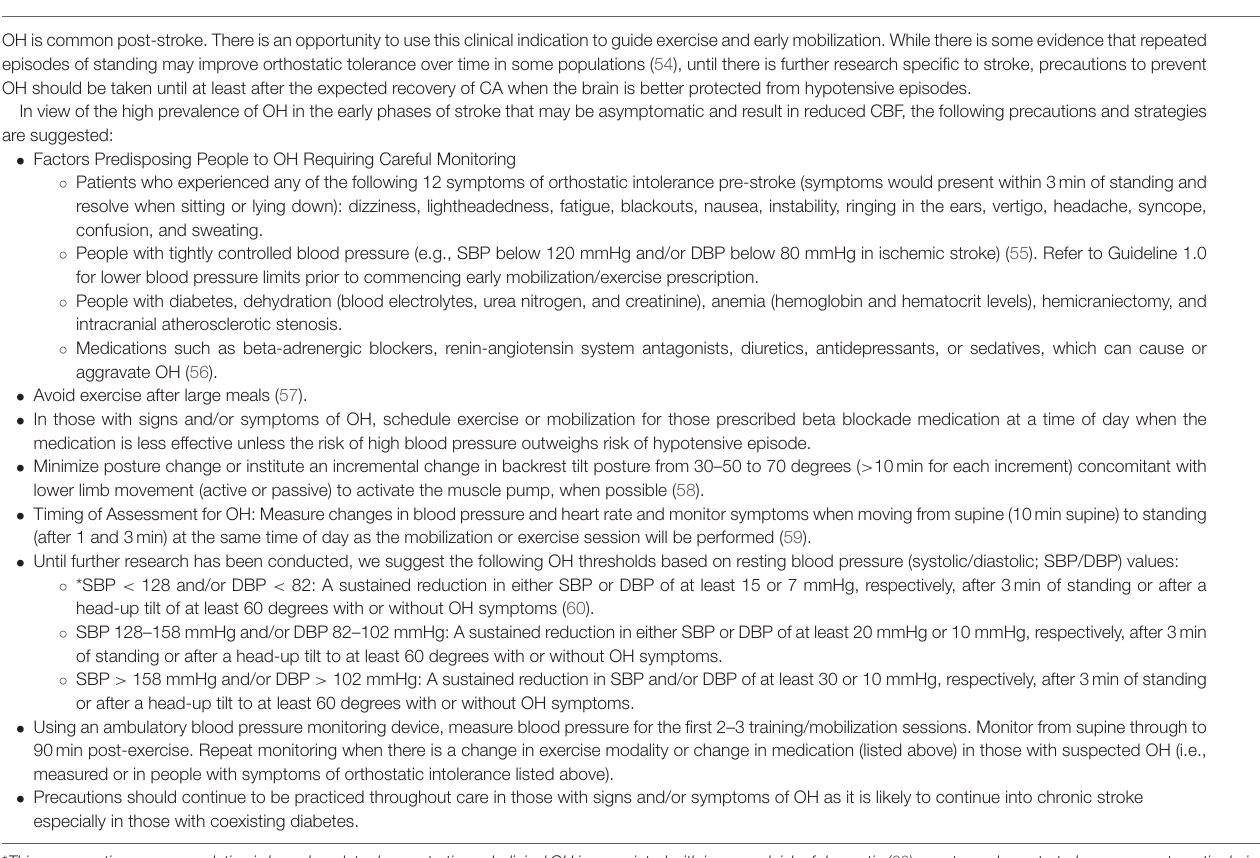
TABLE 4 | Guideline 3.0: Precautions for avoding orthostatic hypotension. OH is common post-stroke. There is an opportunity to use this clinical indication to guide exercise and early mobilization. While there is some evidence that repeated episodes of standing may improve orthostatic tolerance over time in some populations ( 54), until there is further research specific to stroke, precautions to